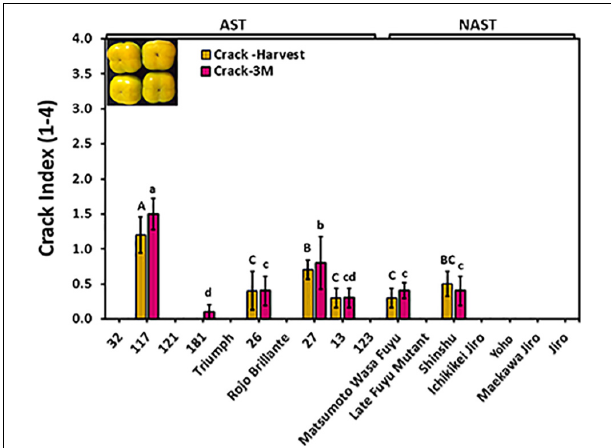
FIGURE 6 | Evaluation of cracks in the different persimmon cultivars. Cracks were evaluated immediately after harvest and following 3 months (3M) of storage. The fruits were dipped in methylene blue and the crack severity was calculated as a crack index. Bars show the average of 5 fruits; ± SE. Different letters indicate a significant difference between treatments according to the Tukey-Kramer HSD test at p ≤ 0.05.